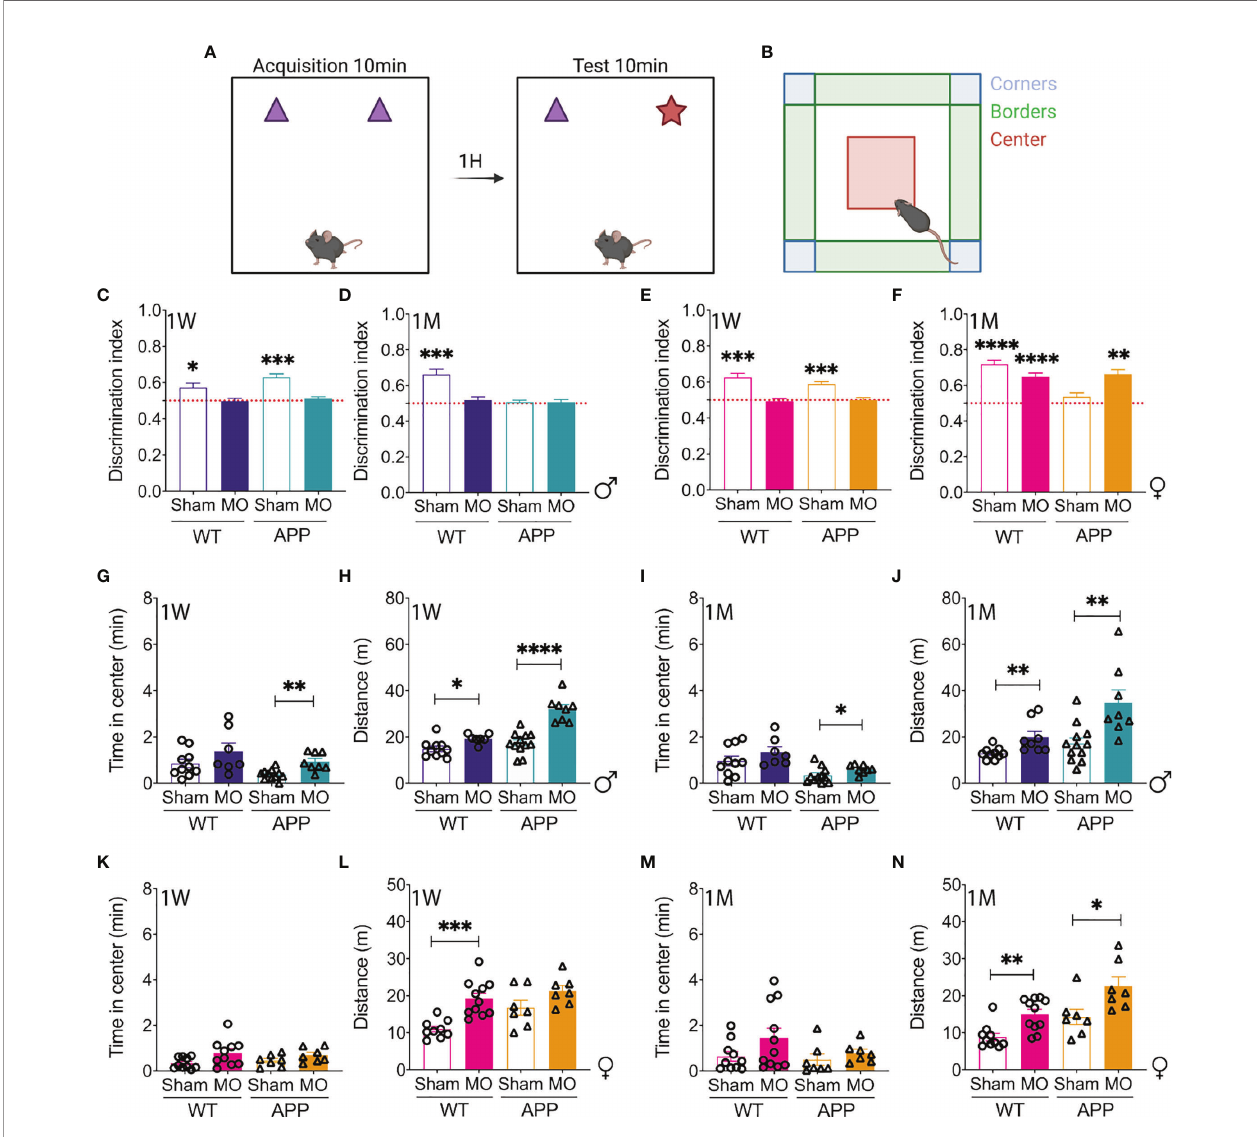
FIGURE 3 | Multifocal microinfarction impairs the cognitive functions of APP/PS1 mice in a sex-dependent manner. A scheme illustrating the (A) Novel Object recognition (NOR) test and (B) open fi eld (OF) test. Created with BioRender.com. Analysis of the discrimination index ratio indicates that (C) sham-operated male WT as well as APP/PS1 mice spend more time exploring the novel object during the test phase whereas MO-operated WT and APP/PS1 spend equal time in exploring both objects, 1 week post-microinfarct induction. At 1 month post-microinfarct induction, (D) sham-operated male WT mice recognize the novel object during the test phase, while sham-operated male APP/PS1 mice as well as MO-operated male WT and MO-operated APP/PS1 mice spend equal time exploring both objects. Analysis of the discrimination index ratio reveals that (E) sham-operated WT and APP/PS1 animals explore more the novel object, in contrast to MO-operated WT and MO-operated APP/PS1 mice that spend equal time exploring both objects, 1 week post-microinfarct induction. At 1 month post-microinfarct induction, (F) sham-operated female WT mice, MO-operated female WT mice and MO-operated female APP/PS1 spend more time exploring the novel object, while the sham- operated female APP/PS1 mice spend equal time exploring both objects. Analysis of the time spent in the center of the OF and the distance moved in the maze indicate that (G) MO-operated male APP/PS1mice spend more time in the center associated with an (H) increased distance travelled in the maze, while MO- operated male WT mice show only an increase in the distance travelled, 1 week post-microinfarct induction. (I) MO-operated male APP/PS1 mice still spend more time in the center of the maze compared to the sham-operated male APP/PS1 mice associated with (J) an increase in the distance travelled, while the MO-operated male WT littermate mice only exhibit an increase in the distance travelled. Analysis of the same parameters in females show that (K) no changes are noted in the time spent in the center of the maze while (L) an increase in the distance travelled is observed in MO-operated WT mice, 1 week post-microinfarct induction. At 1 month post-microinfarct induction, (M) no changes are noted in the time spent in the center of the OF. However, (N) an increase in the distance travelled is observed in MO-operated WT mice and APP/PS1 mice compared to sham-operated mice. Data are mean ± SEM (n = 5-10 animals/group). *P < 0.05/**P < 0.01/***P < 0.001/ ****P < 0.0001 compared to 0.5 (one sample t-test) for the NOR, and *P < 0.05/**P < 0.01/***P < 0.001/****P < 0.0001 compared to sham-operated WT or APP/ PS1 mice (two-tailed unpaired t-test) for the remaining